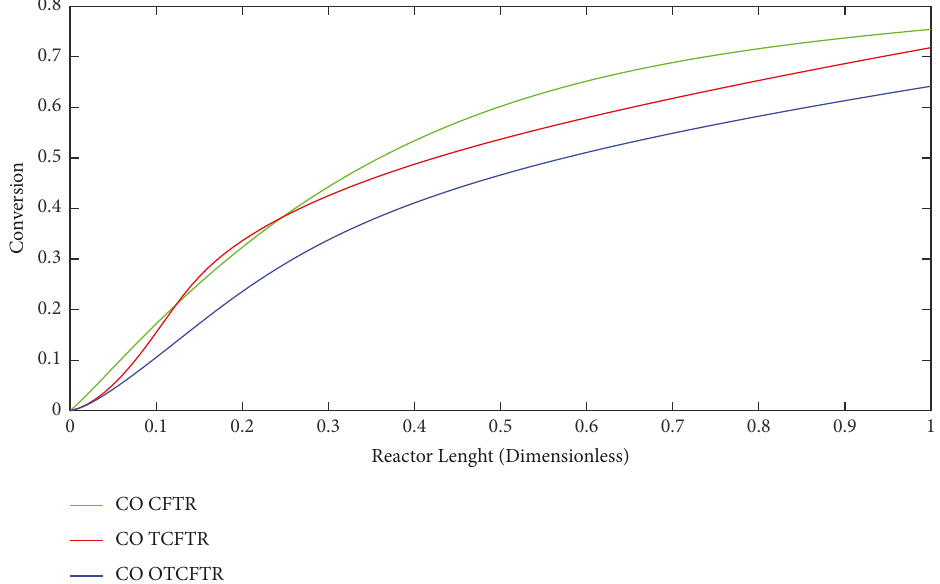
Figure 26: Conversion percentage of carbon monoxide in various modes along the reactor length.